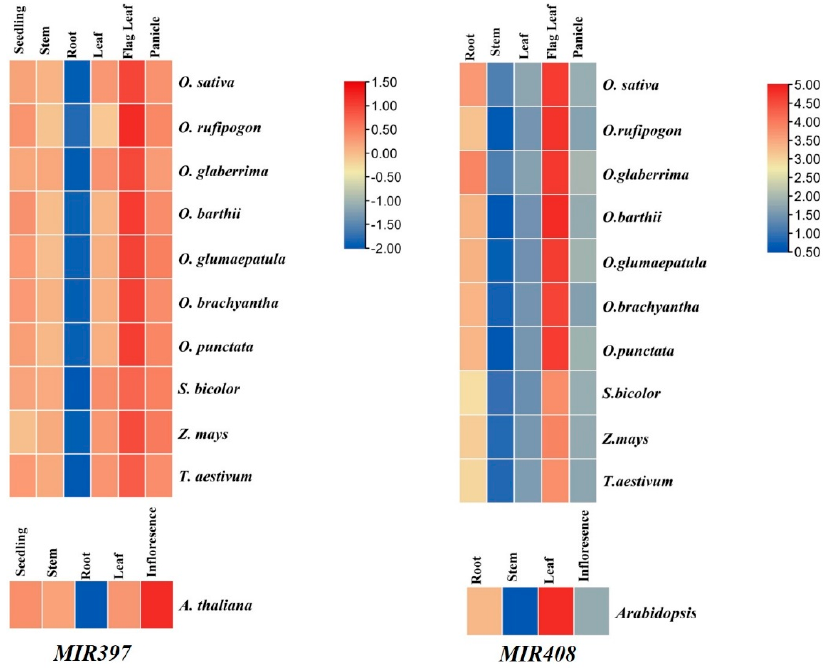
Figure 9. Differentially expressed MIR397 and MIR408 across different Oryza and poaceae species in tissue-specific manner. Expression pattern was obtained via qRT-PCR. Each block shows log2-fold expression in stem, leaf, root, and inflorescence.